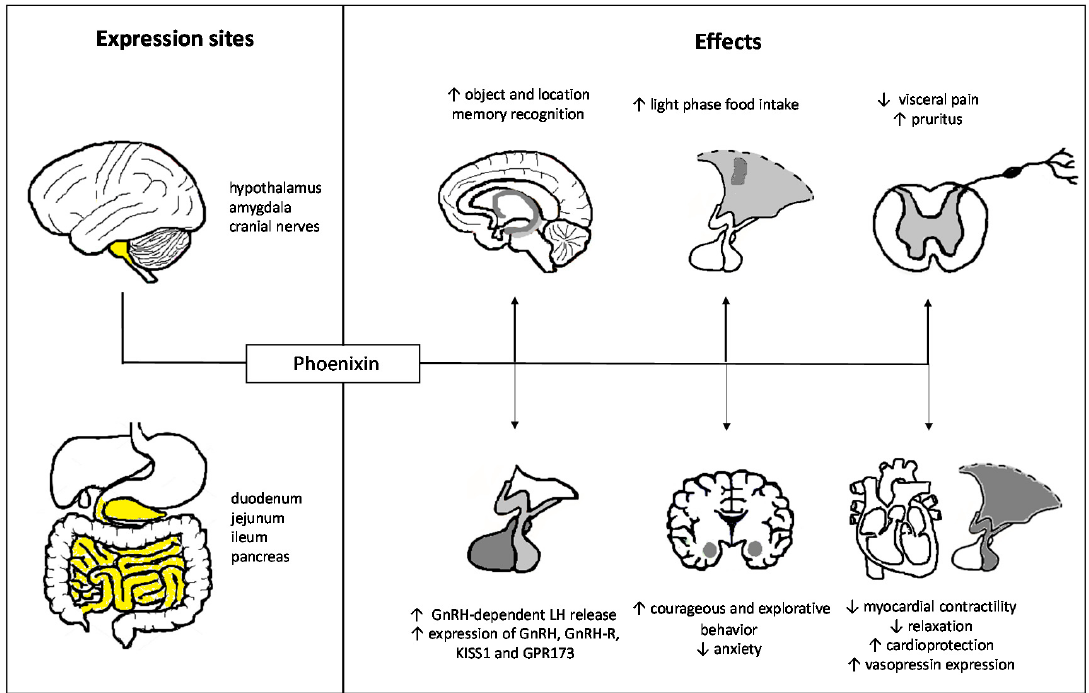
Figure 2. Pleiotropic effects of phoenixin. ↑ , increase; ↓ , decrease. Highlighted areas in yellow represent expression sites of phoenixin.